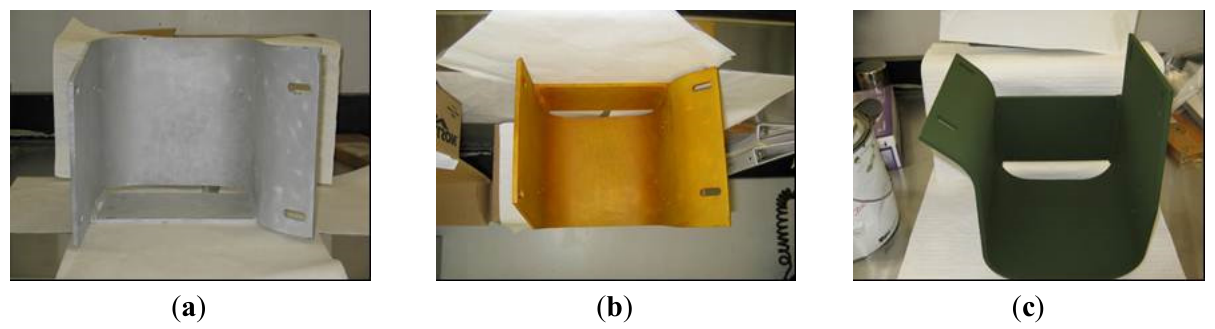
Figure 6. Coating procedure employed for de-painting and re-painting using BAM-PPV as